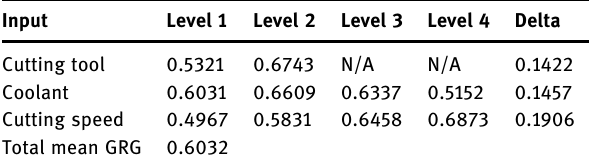
Table 7: Response table for